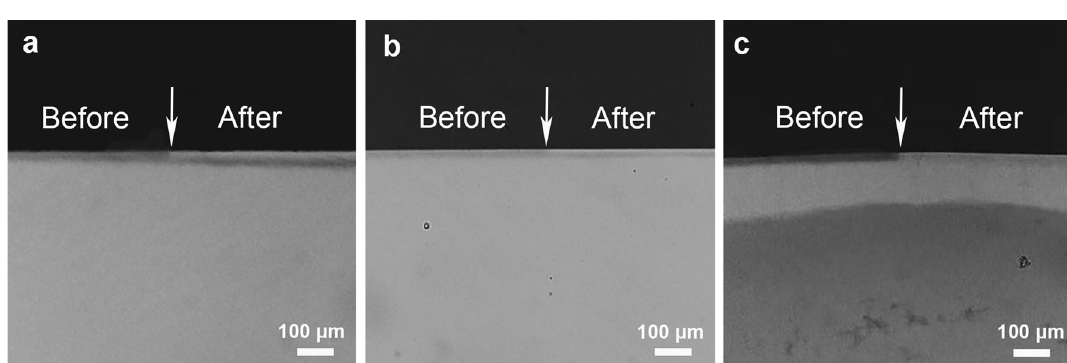
Figure 3. TMR microradiographs of enamel sections before and after 14 days pH cycling. ( a ) double distilled water (DDW) alone, ( b ) GERM CLEAN, ( c ) 1000 ppm fluoride (NaF). White arrows indicated the boundary before and after the pH cycling. The DDW group showed the deepest lesion depth and the lowest density of the